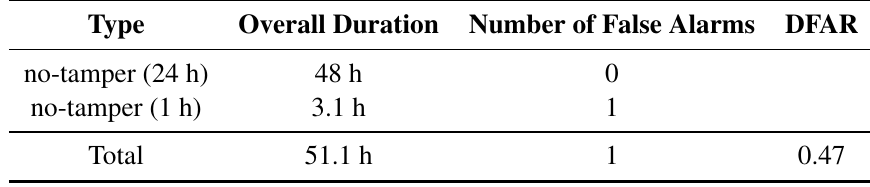
Table 6. Daily false alarm rate of the proposed